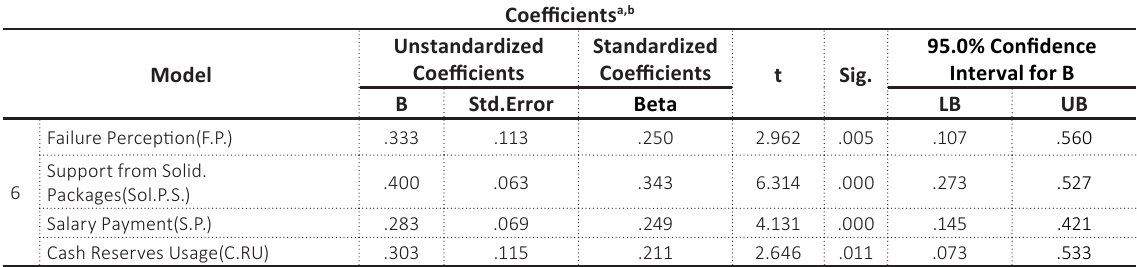
Table 3. Linear regression coefficients with the dependent variable “Covid-19 Impact”